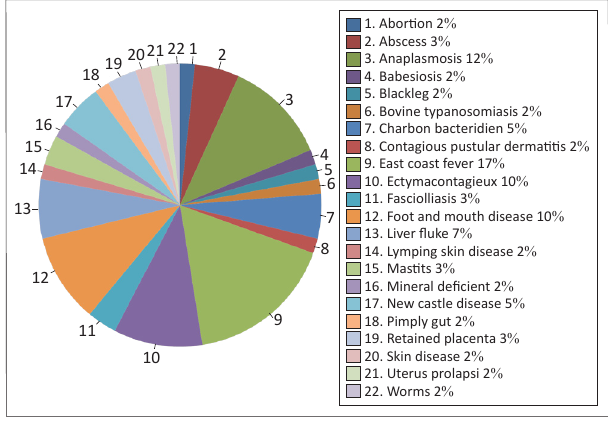
FIGURE 9: The percentage of animal disease cases for the Kagera River Basin collected over a period of eight months, September 2012 – May 2013.